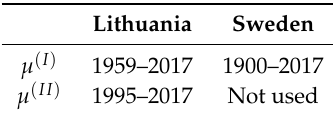
Table 1. Time periods modelled by drifts of time varying index when fitting with the Lithuanian and Swedish